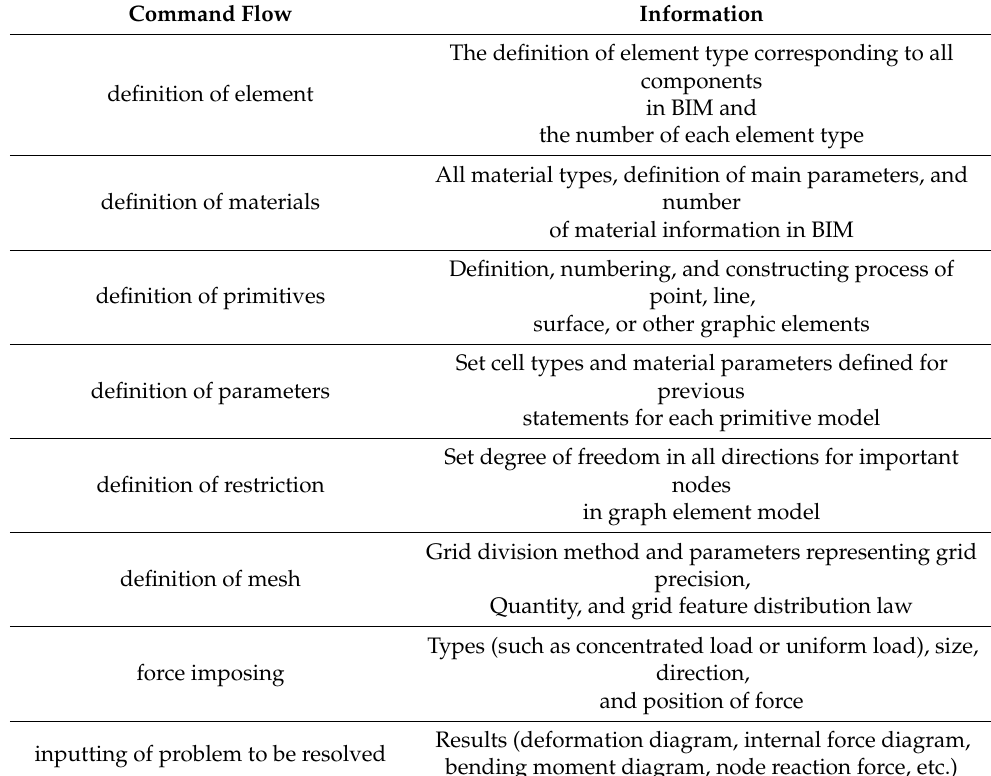
Table 3. Information requirements based on command flow analysis of finite element model.